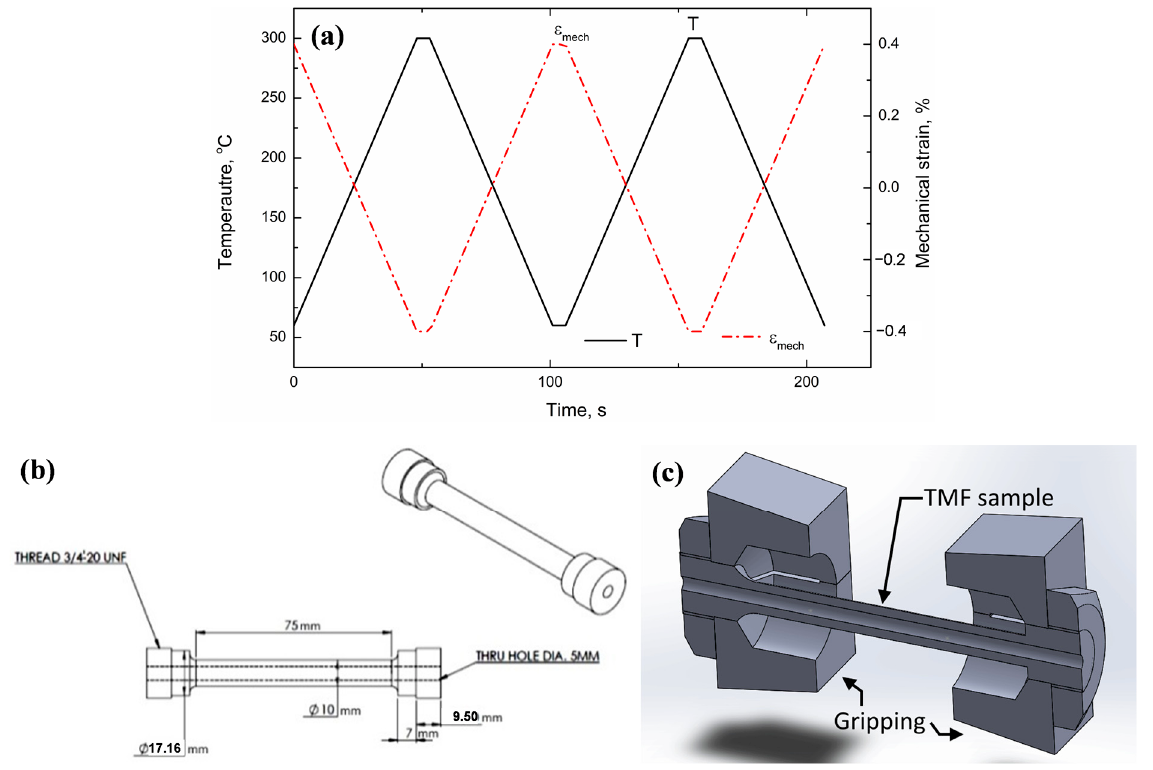
Figure 1. Schematic illustration of OP-TMF at 0.4% strain amplitude ( a ), TMF sample dimensions ( b ), and the setup with gripping blocks ( c ).